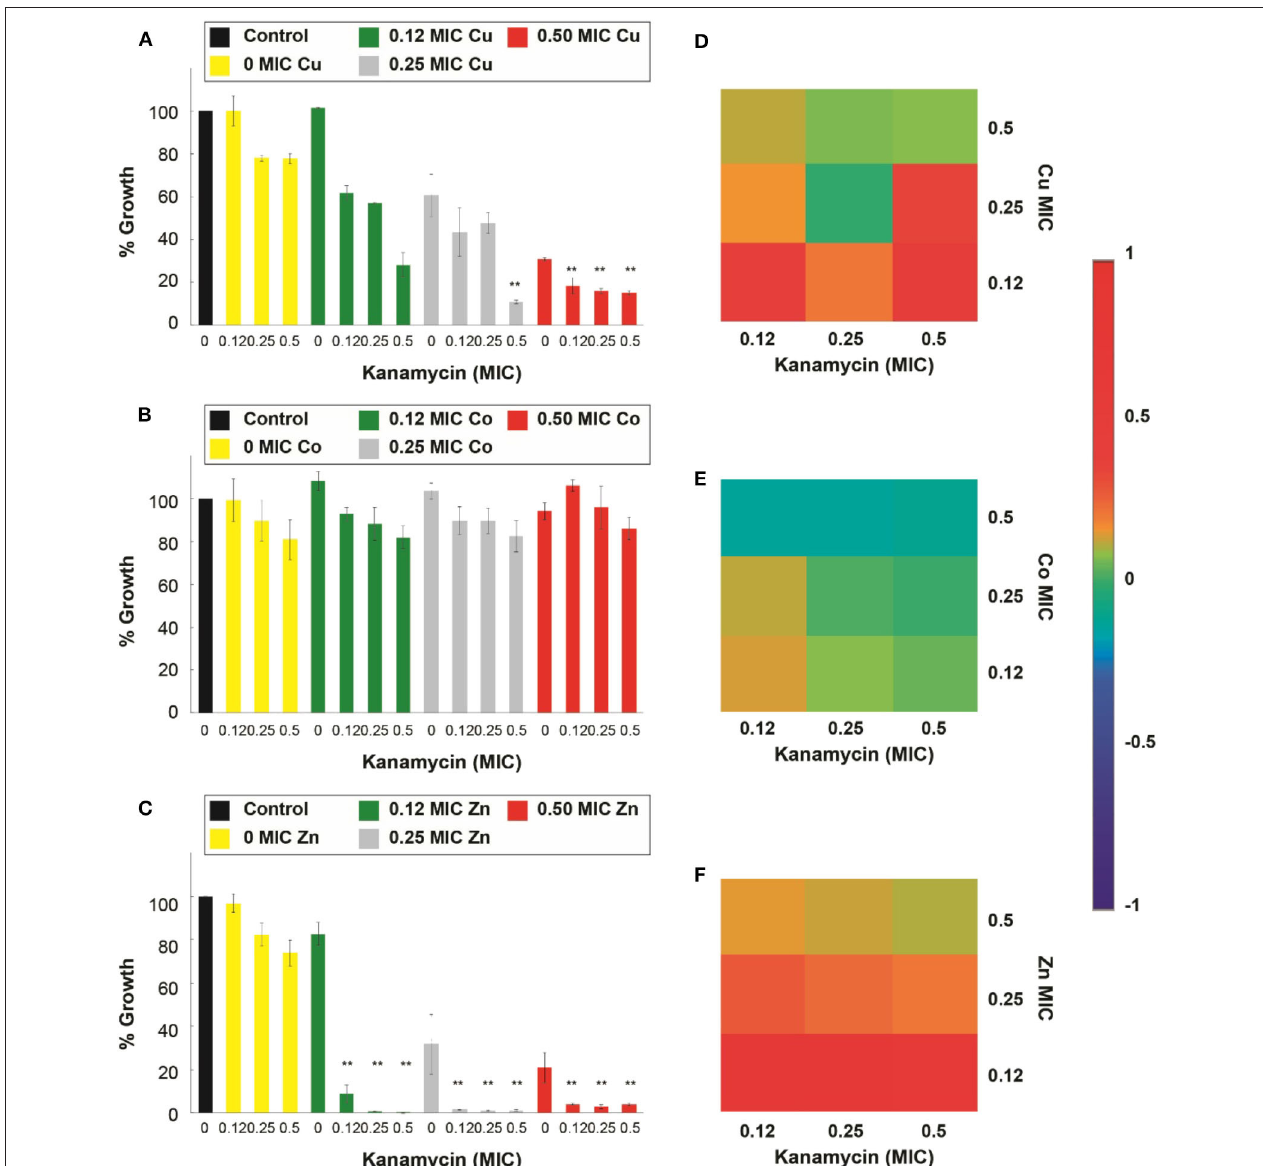
FIGURE 8 | Antimicrobial effect and interactions of ATMCs in kanamycin-resistant S. aureus . Growth percentage by sub-inhibitory concentrations of metal ion-antibiotic combinations: (A) Cu 2 + -kanamycin, (B) Co 2 + -kanamycin, and (C) Zn 2 + kanamycin against S. aureus-Kan . Classification of the different interactions between metal ion-antibiotic combinations. The interactions of (D) Cu 2 + -kanamycin, (E) Co 2 + -kanamycin, and (F) Zn 2 + -kanamycin combinations are classified as synergistic, additive, or antagonist, value > 0, = 0, and < 0, respectively. Each experiment was done in triplicates. **Corresponds to a significant difference ( p < 0.05) concerning the control and each of the individual treatments. Error bars correspond to the standard deviation from experiments performed in